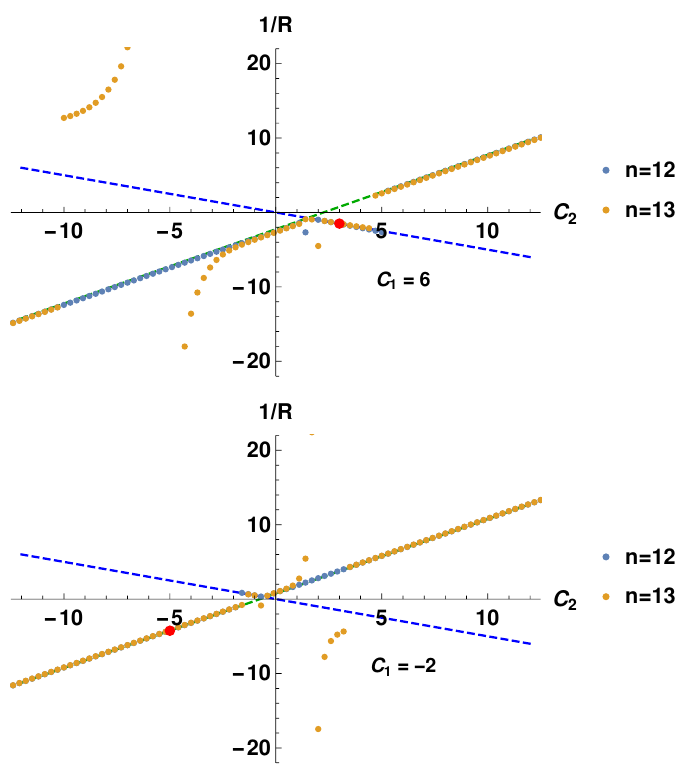
Figure 13 . The radius of convergence of the full infrared-renormalized amplitude as a function of the colour operators. In these plots the dots represent the value of 1 =R , for the corresponding value of C 1 = (2 C A T 2 ) and C 2 = ( C A T 2 ), based on the Pad(cid:19)e approximant analysis for ‘ = 11 and t t (cid:0) (cid:0) ‘ = 12, as indicated in the plots. We superimpose two linear lines, which determine the dependence of 1 =R on the colour operators, as summarised by eq.